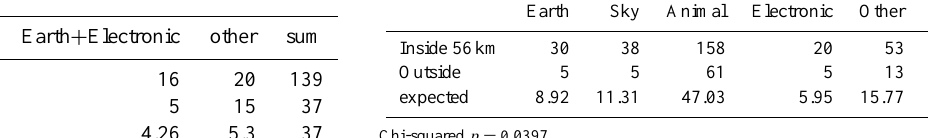
Table 1. Chi-squared test comparing data of day before, with days 2–4 before.